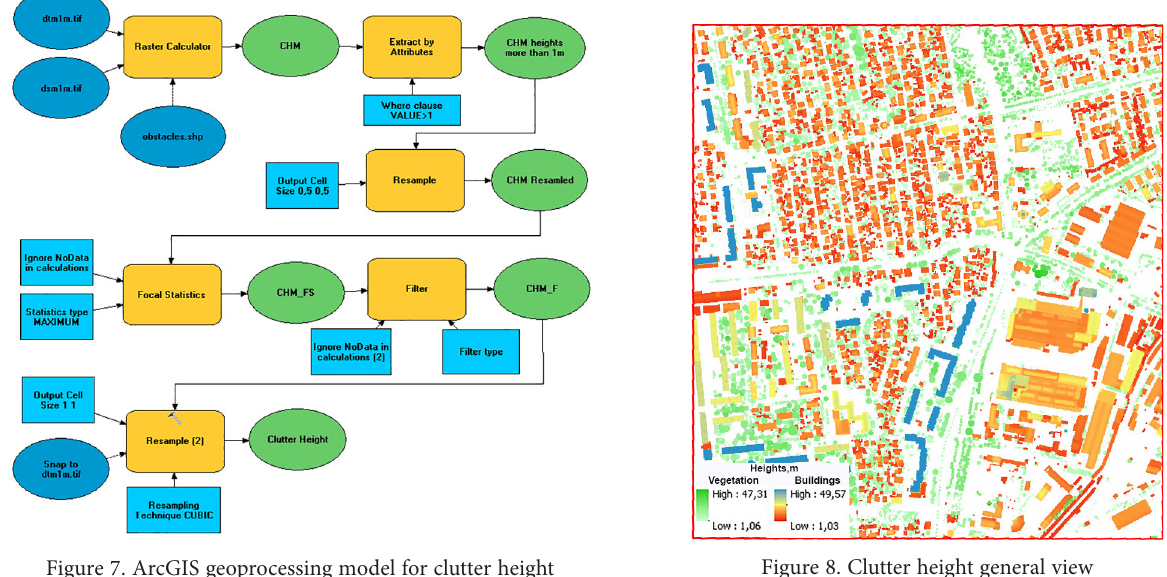
Figure 8. Clutter height general